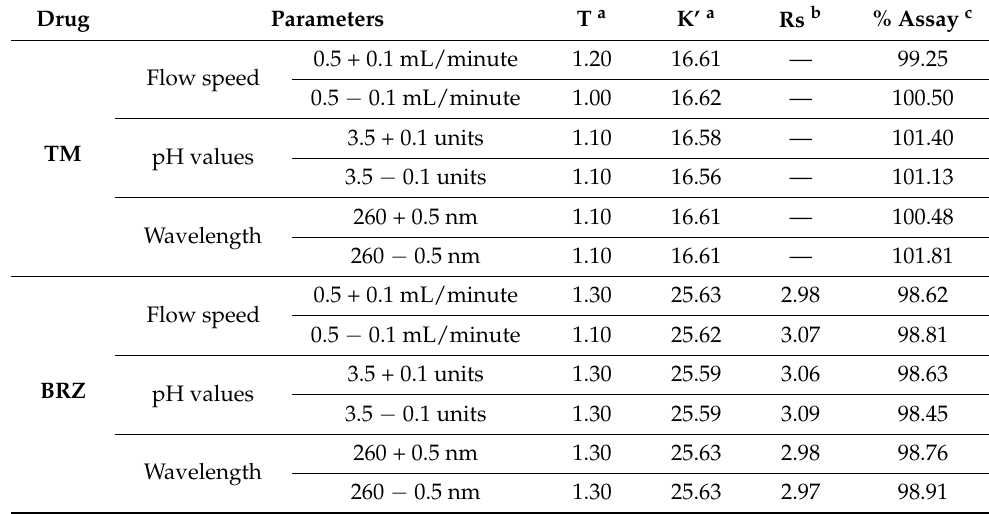
Table 4. Data for robustness for the HPLC Method